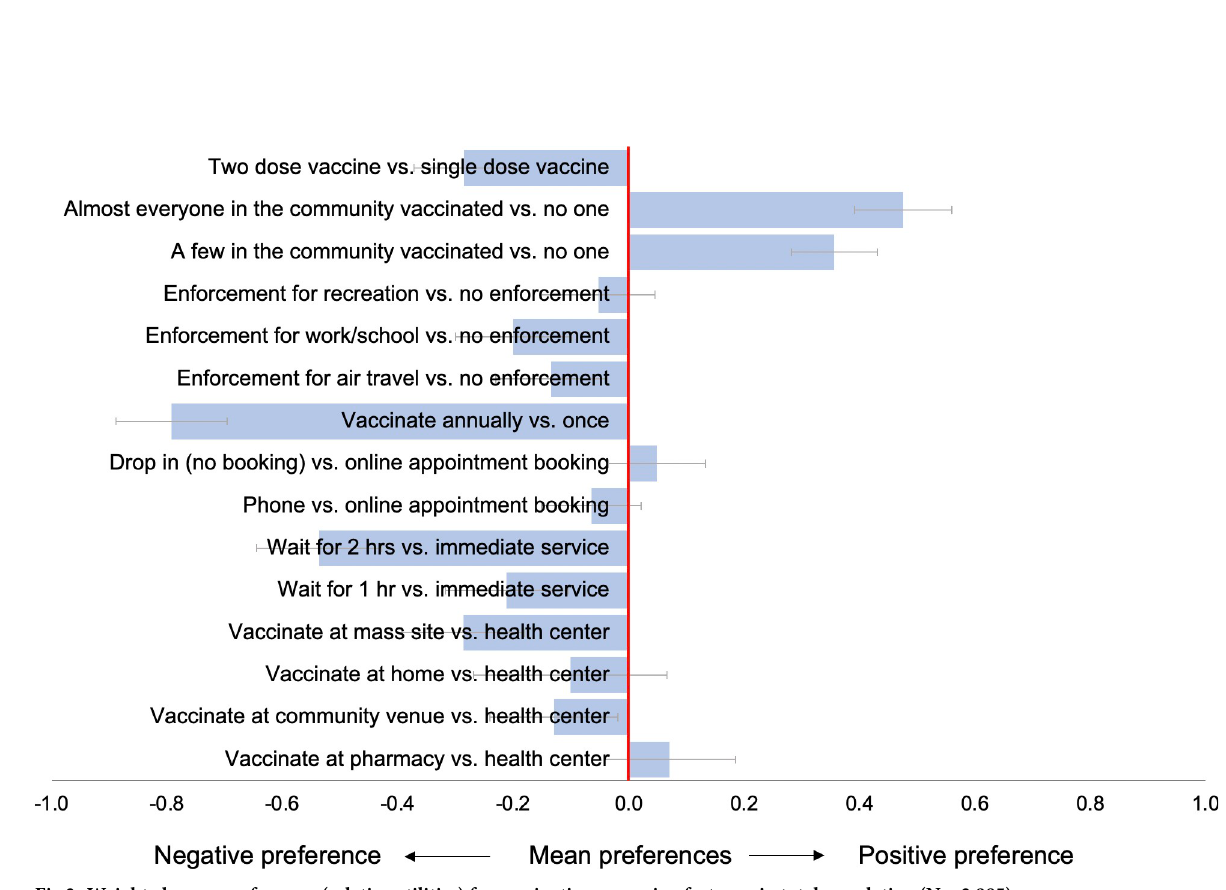
PLOS ONE | https://doi.org/10.1371/journal.pone.0256394 August 20,